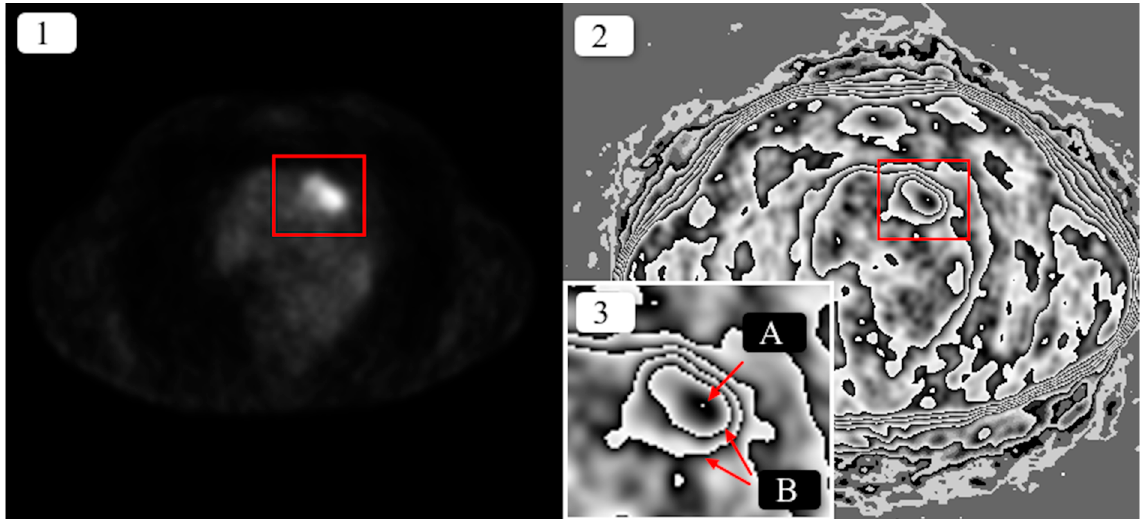
Figure 1. Result of the transformation of a single positron-emission tomography (PET) DICOM image of the lung using the pre-processing method for contouring the uptake levels of 18 F-fluorodeoxyglucose ([18F] FDG) (PCUL-FDG) method. In both versions of the axial projection image, the red rectangle marks an area with increased [18F] FDG uptake in a pulmonary nodule within a 3.3-mm-thick layer. ( 1 ) Original image, ( 2 ) transformed image, ( 3 ) close-up of the section marked with red, where A: maximum [18F] FDG uptake, B: nested uptake contours .